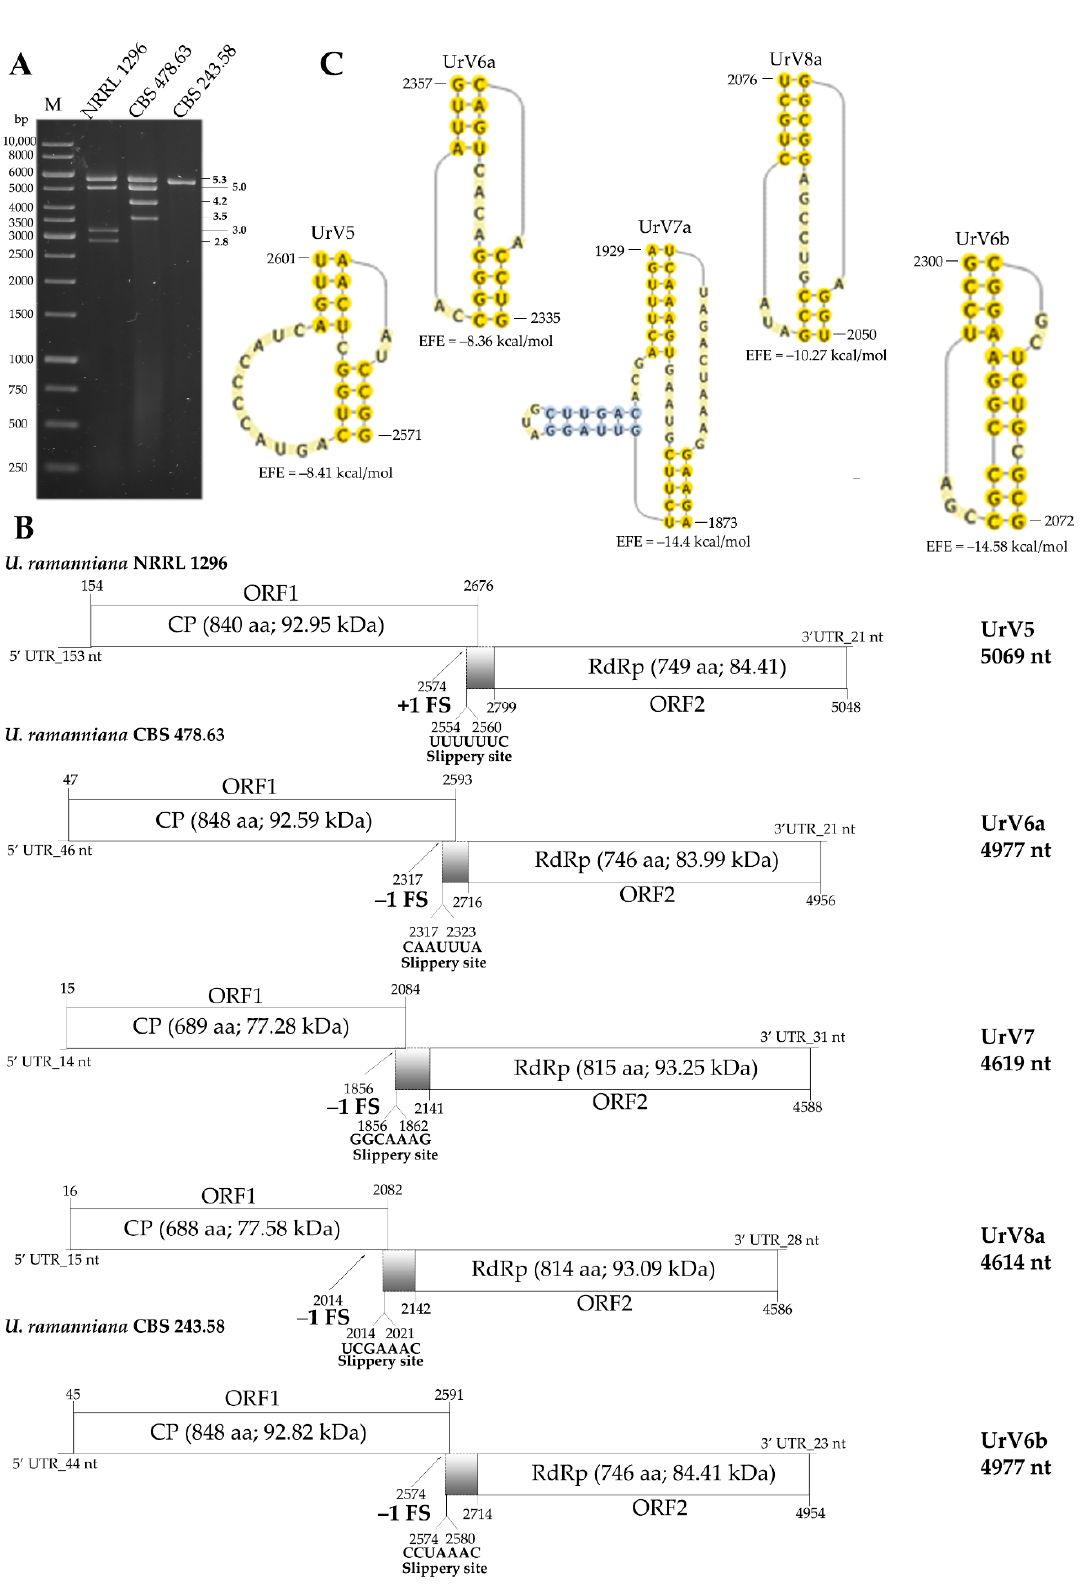
Figure 2. Gel electrophoresis pattern and genomic organization of the detected dsRNA genomes in three mycovirus-harboring Umbelopsis ramanniana strains. ( A ) Agarose gel electrophoresis of dsRNA fragments purified from the mycovirus-harboring U. ramanniana strains. Lane M, GeneRuler 1 kb DNA Ladder (Thermo Scientific); Lane 1, Umbelopsis ramanniana NRRL 1296; Lane 2, Umbelopsis ramanniana CBS 478.63; Lane 3, Umbelopsis ramanniana CBS 243.58. The sizes (kbp) of the detected